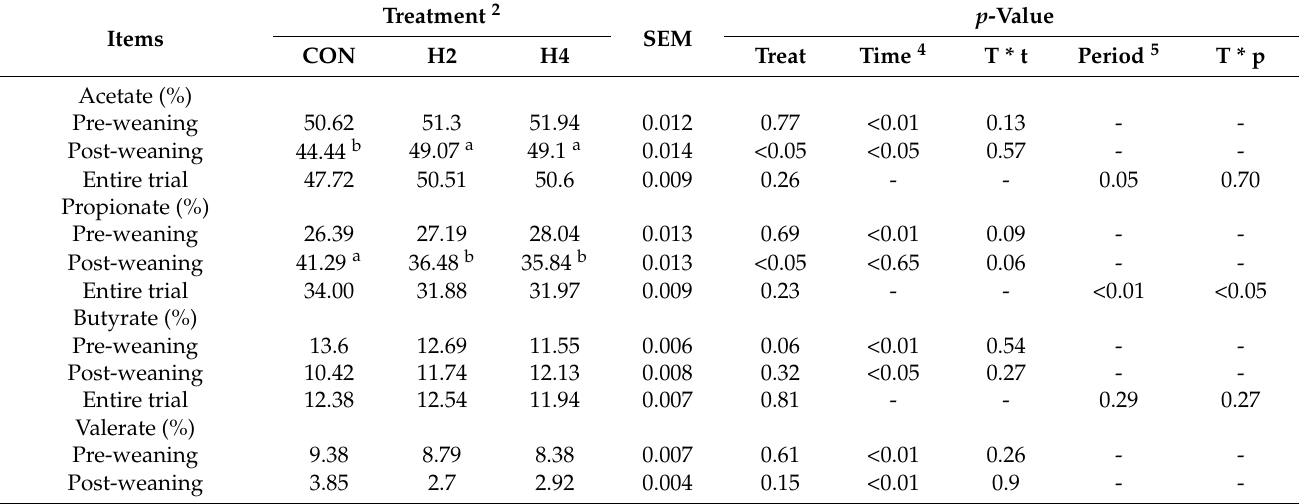
Table 6. Effects of hay supplementation at different ages on rumen volatile fatty acids in dairy calves during